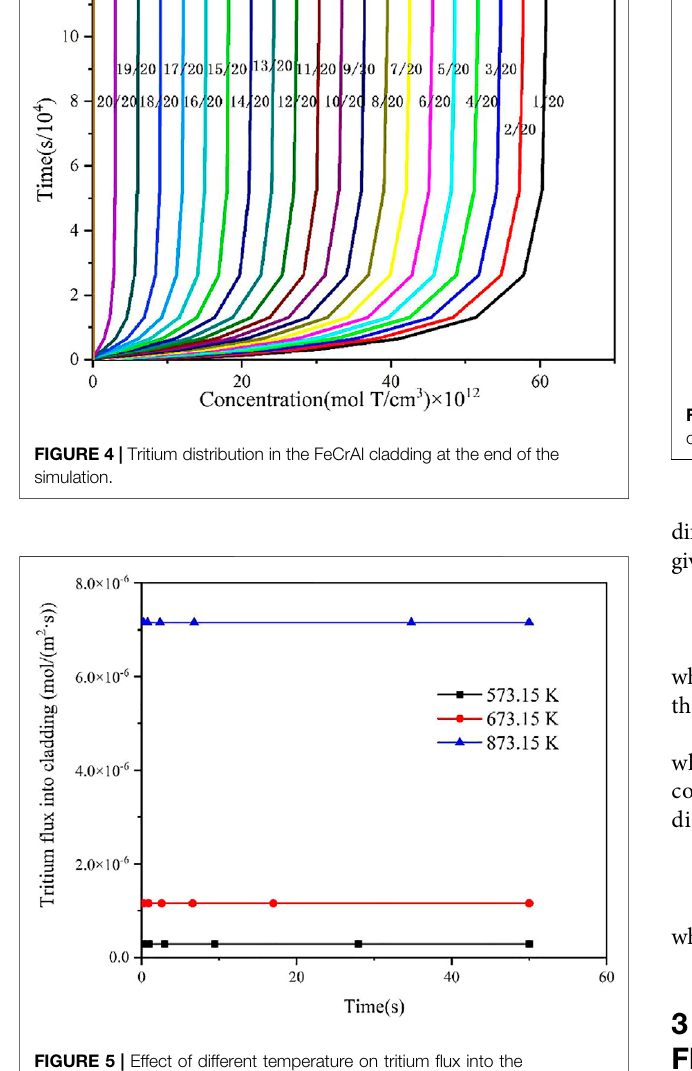
FIGURE 5 | Effect of different temperature on tritium fl ux into the cladding inner surface.